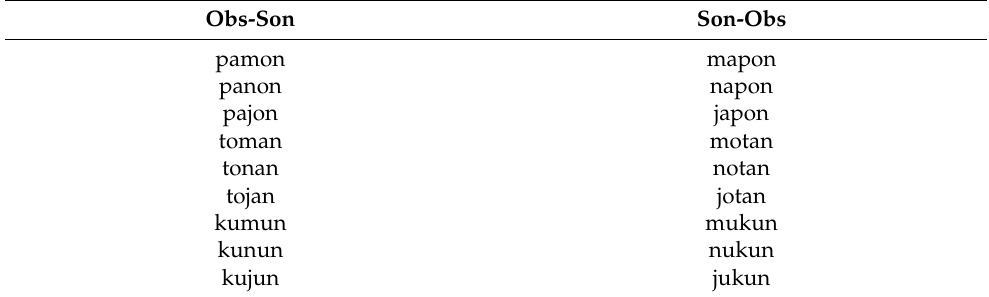
Table 2. The list of stimuli for Japanese speakers (Experiment 1). Note that <j> represents a palatal glide, not a post-alveolar voiced affricate. <n> is usually transcribed as a uvular nasal